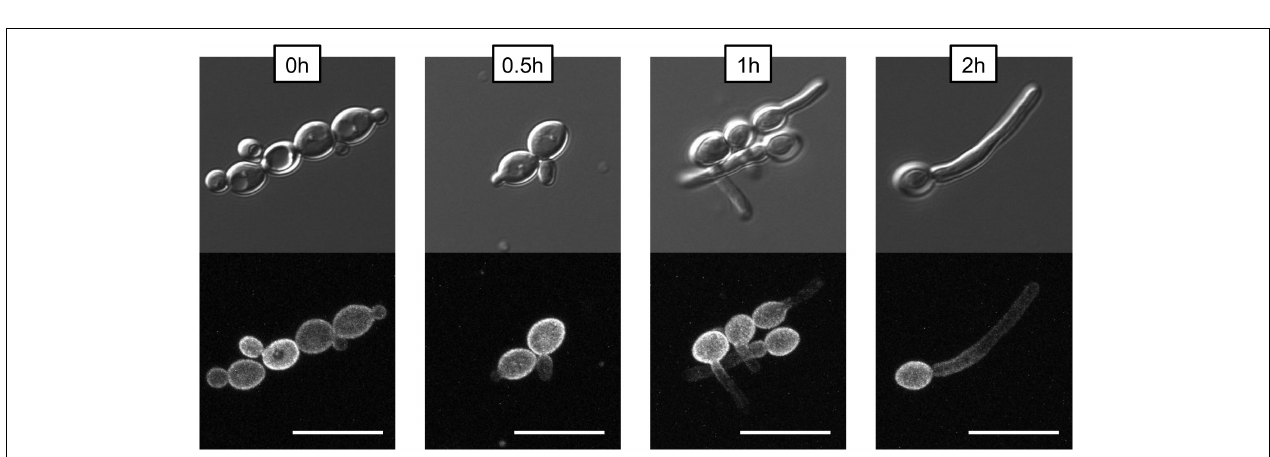
FIGURE 9 | Non-homogenous distribution of Pma1p in hyphae. A wild-type strain in which PMA1 was C-terminally tagged with GFP was diluted to a concentration of 5 × 10 6 cells per mL and grown in YNB+20% FCS for 4 h. Cells were imaged using a confocal microscope to demonstrate that hyphal tips are not simply out of the field of view. For the GFP fluorescent image, a Z-stack comprised of 0.2-micron thick slices is shown. Pma1-GFP is distributed evenly across the plasma membrane in yeast cells, but is less prominent along the hyphae of filamenting cells. Scale bars indicate 10 µ